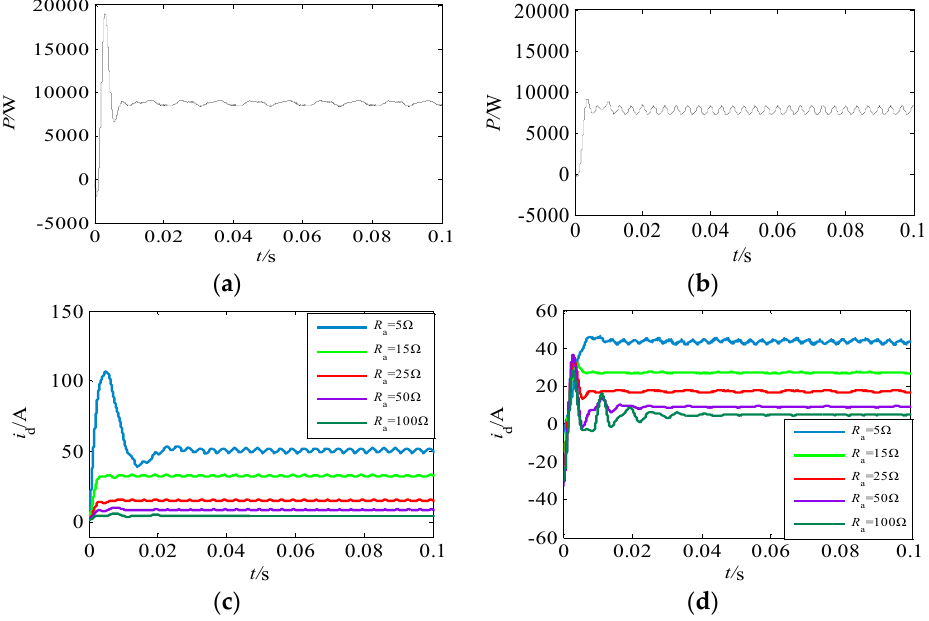
Figure 5. Comparison of static and dynamic stability under two strategies. ( a ) The output active power of the inverter under a passivity-based control (PBC) strategy; ( b ) The output active power of the inverter under the traditional PI control strategy; ( c ) The d -axis current under a PBC strategy; and ( d ) The d -axis current under the traditional PI control strategy.